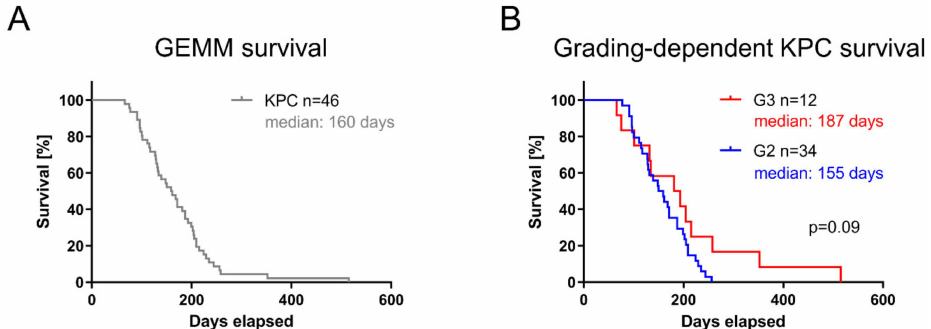
Figure 1. Pancreatic ductal adenocarcinoma (PDAC) heterogeneity in Kras G12D /+ ;LSL-Trp53 R172H /+ ; Pdx-1-Cre (KPC) mouse model. ( A ) Survival of KPC cohort (n = 46) with median survival of 160 days. ( B ) PDAC establishment histopathologically confirmed and respective tumors